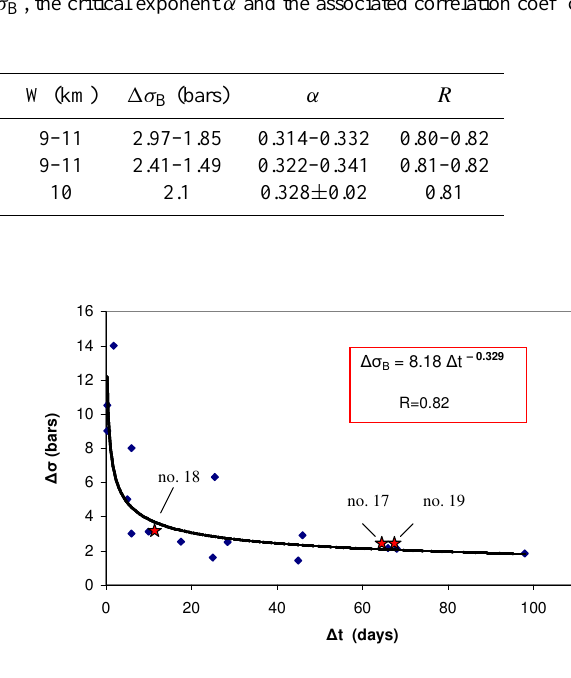
Fig. 2. The plot of the relation between the stress drop and the lead Fig.2 time of all “non thrust” earthquakes, which are listed in Table 1. Event no. 11 is excluded. The new events no. 17, 18, and 19 are marked with stars. The derived power law equation along with the corresponding correlation coefficient R are displayed on the top of the